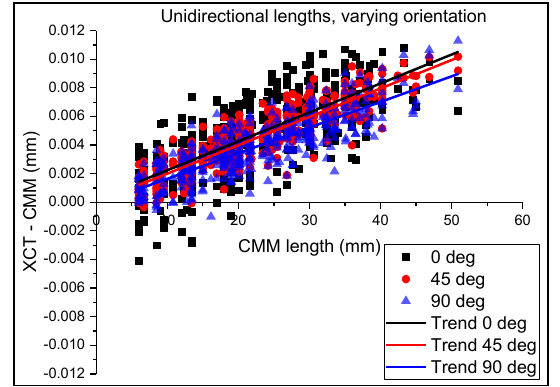
Figure 6: Deviation between unidirectional lengths for holeplate at 1.6 times magnification in three orientations